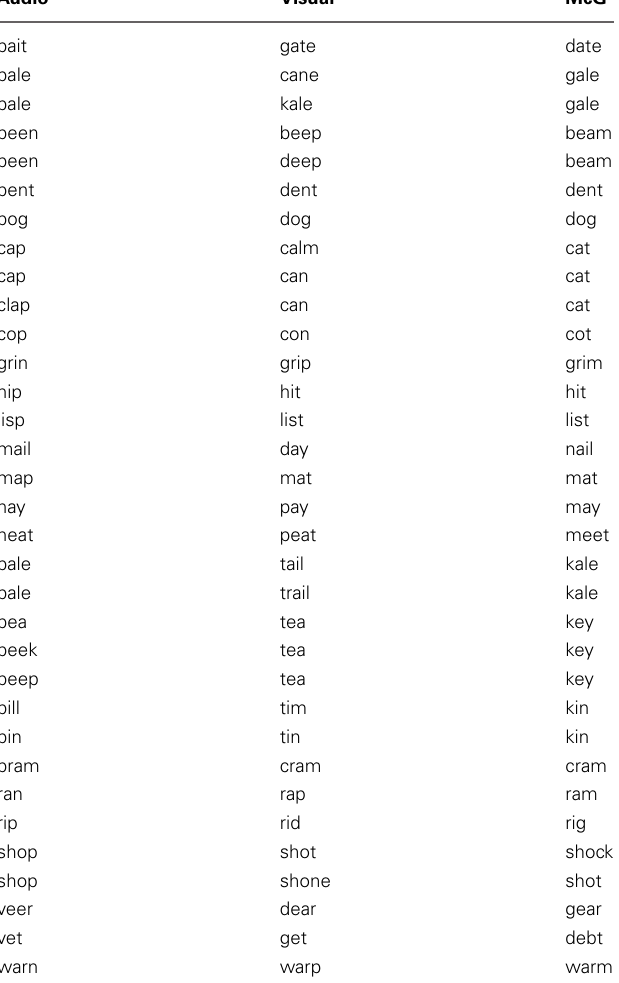
Table A1 | List of items used in the